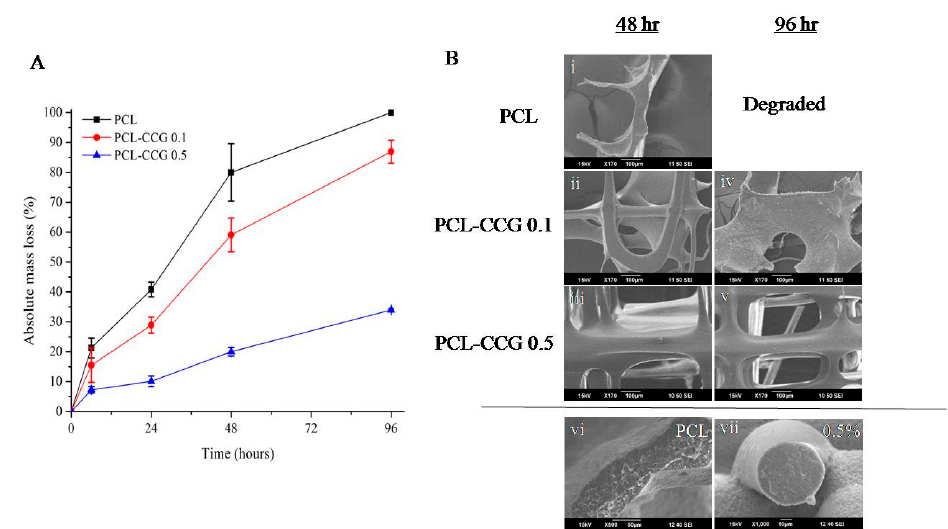
Figure 8. Mass loss study of MEW PCL scaffolds via enzymatic degradation ( A ); SEM images of scaffolds after enzymatic degradation ( B ) at 48 h (Bi–iii) and 96 h (Biv,v). High magnification cross-sectional images of PCL (B vi) and PCL-CCG 0.5 (B vii).